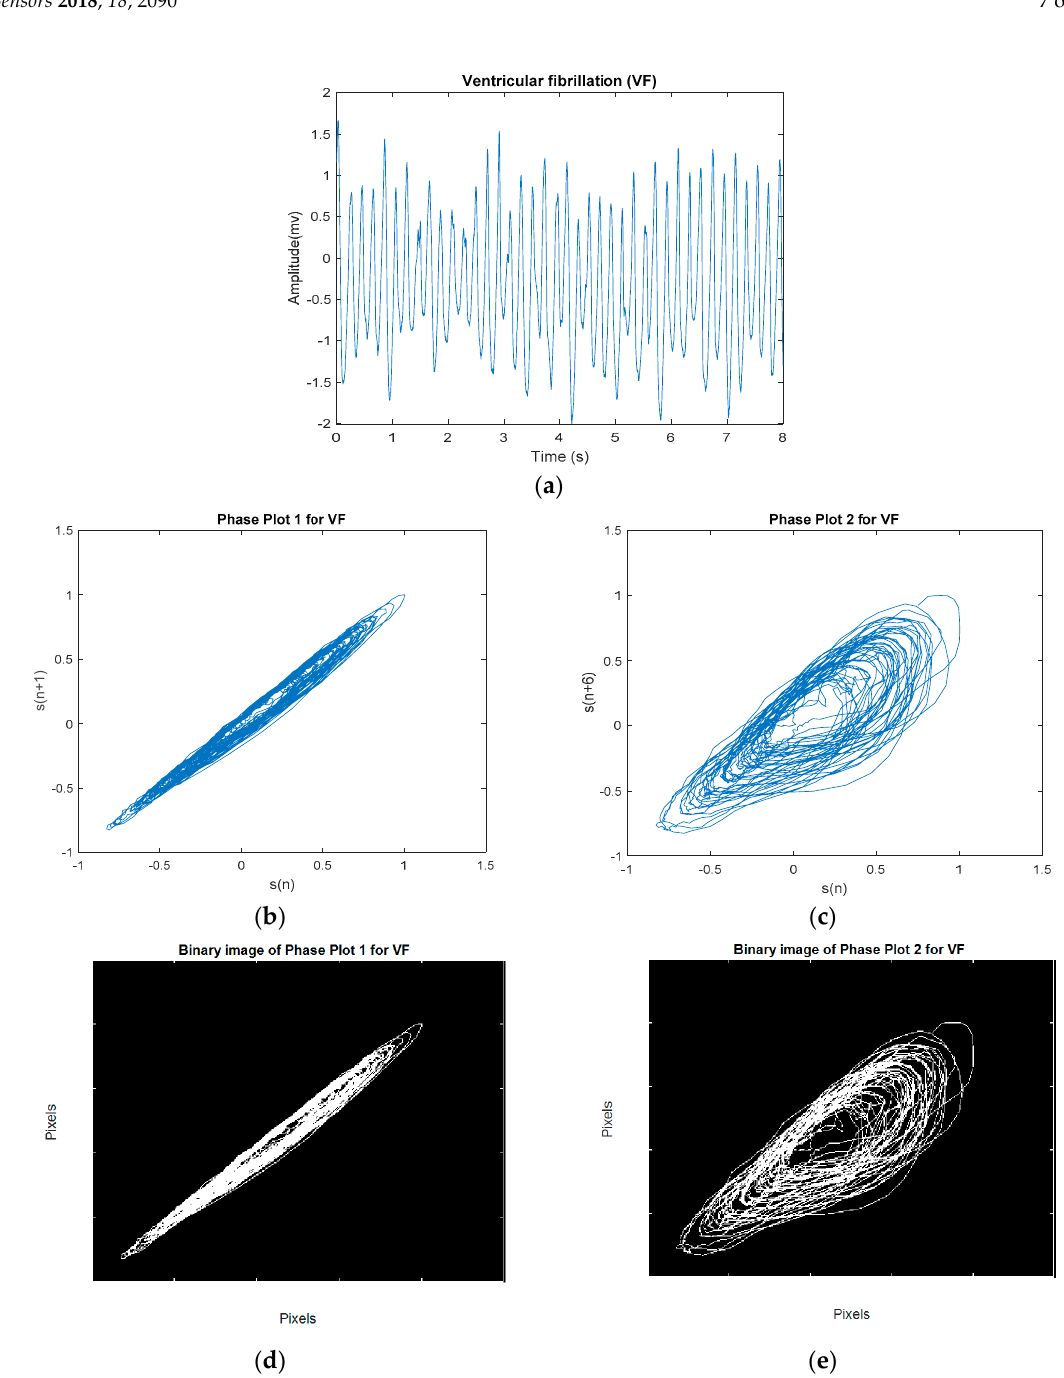
Figure 4. ( a ) An example VF segment. ( b ) Phase plot of segment with a 1-sample lag. ( c ) Phase plot of segment with a 5-sample lag. ( d ) Related binary image of ( b ). ( e ) Related binary image of ( c ).